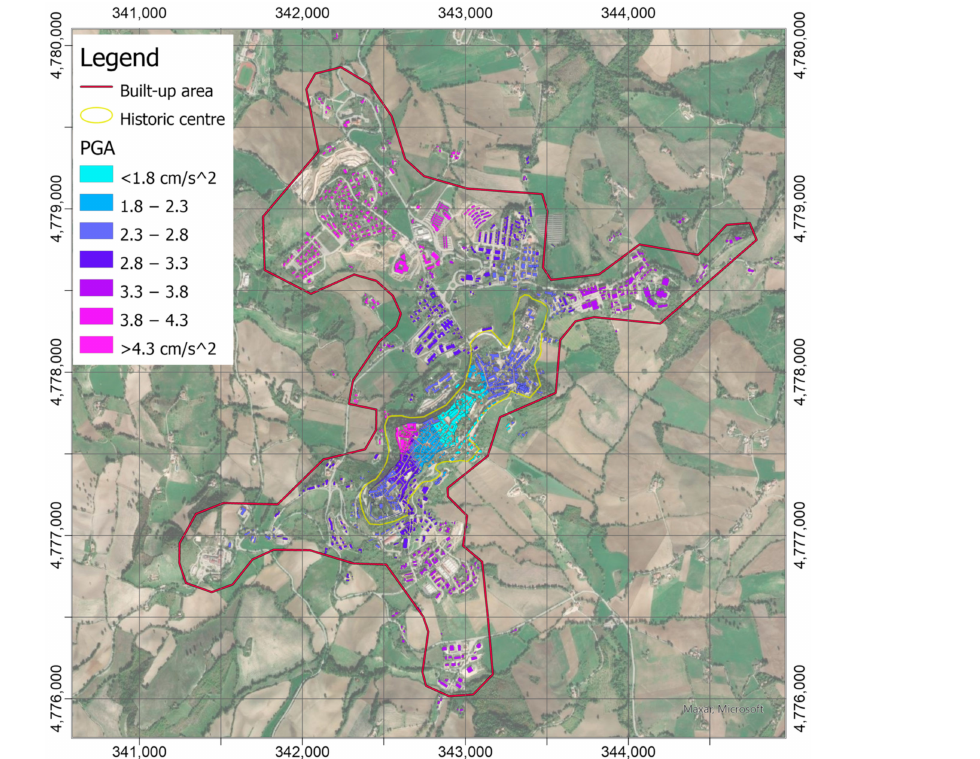
Figure 10. PGAs (in cm/s 2 ) assigned to the buildings in the built-up area of Camerino. The map was obtained by the spatial join of the position of the buildings and information provided by shakemap in Figure